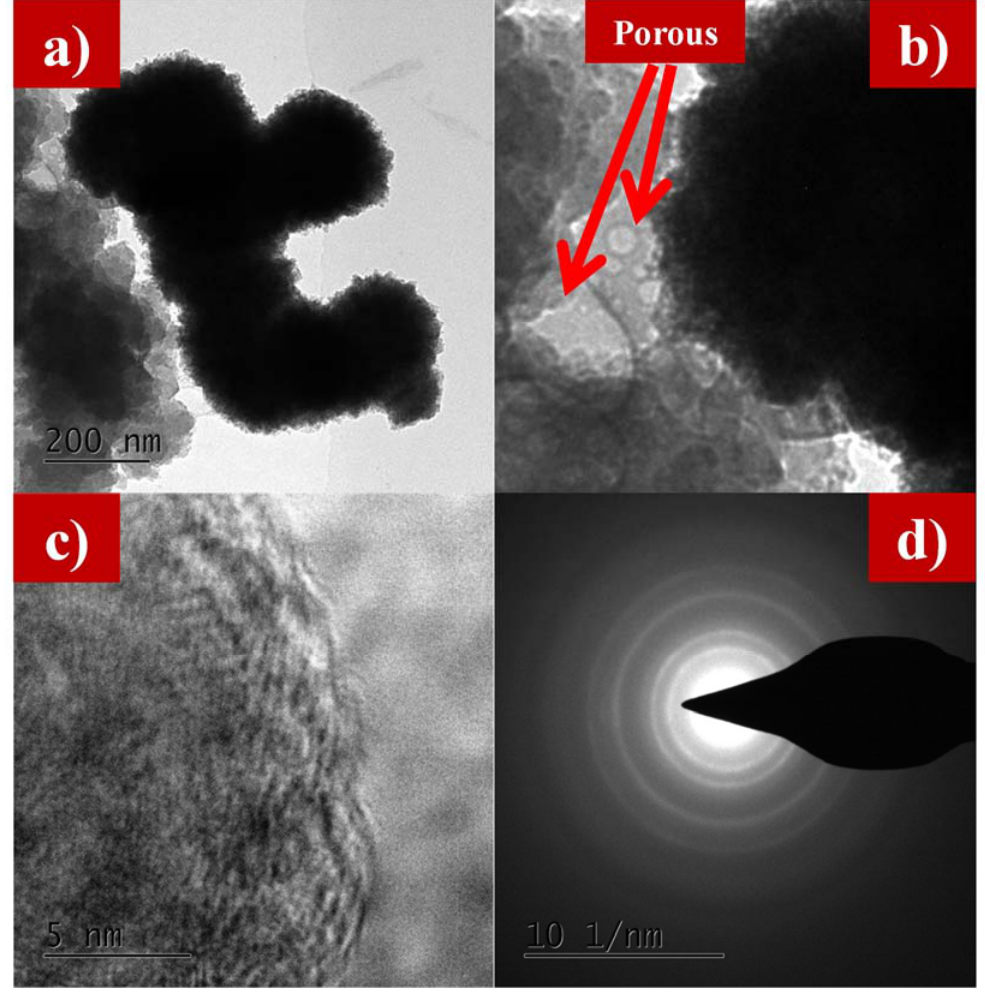
Figure 6. ( a ) TEM images at 200 nm, ( b ) porous nature, ( c ) amorphous nature, and ( d ) SAED of carbon in as-synthesized LFS@ESM.